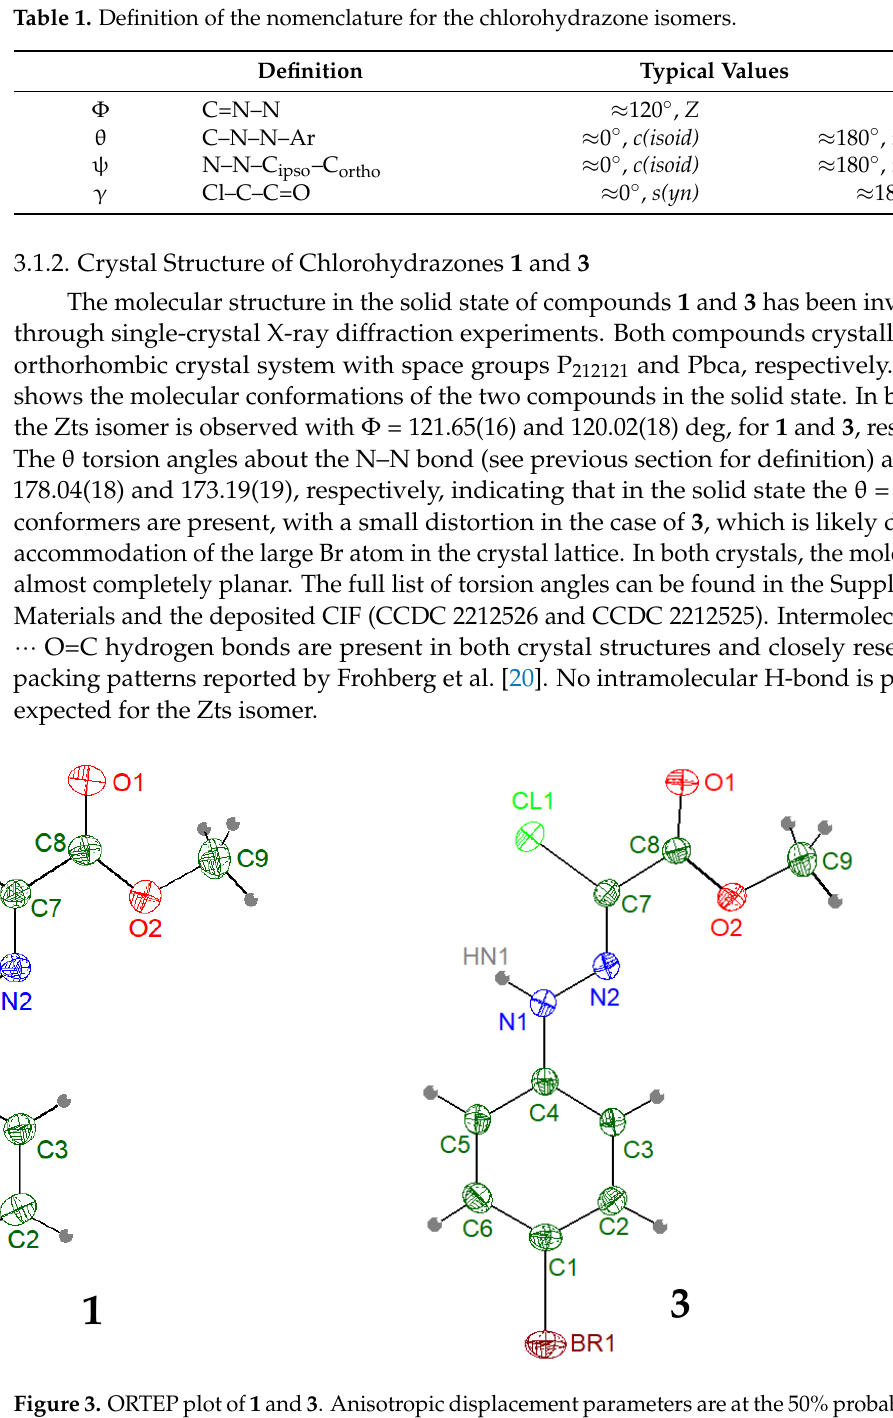
Figure 3. ORTEP plot of 1 and 3 . Anisotropic displacement parameters are at the 50% probability level. Crystal packing of compound 1 down c and a axes together with relevant intermolec- ular interactions are reported in Figure 4. The overall motif is that of zigzag ribbons extended along the b axis. Geometrical parameters for the N–H ··· O=C intermolecular hydrogen bond which packs together molecules in the crystallographic bc plane are as follows: d [HN1 ··· O1( − x, y + 1 , − z + 3/2)] = 2.210(2) Å; N1-HN1 ··· O1( − x, y + 1 , − z + 2 2 3/2) = 159.64(10)